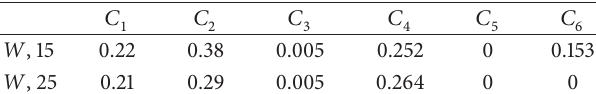
Table 13: Criteria weight’s changes during time.